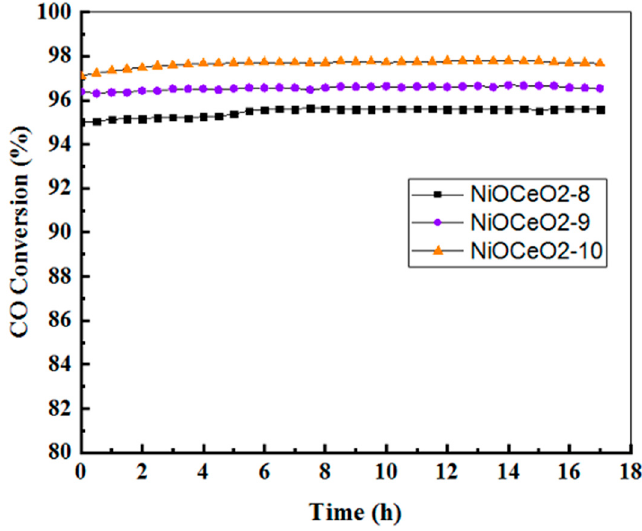
Figure 7. Stability tests for CO methanation at 250 °C.